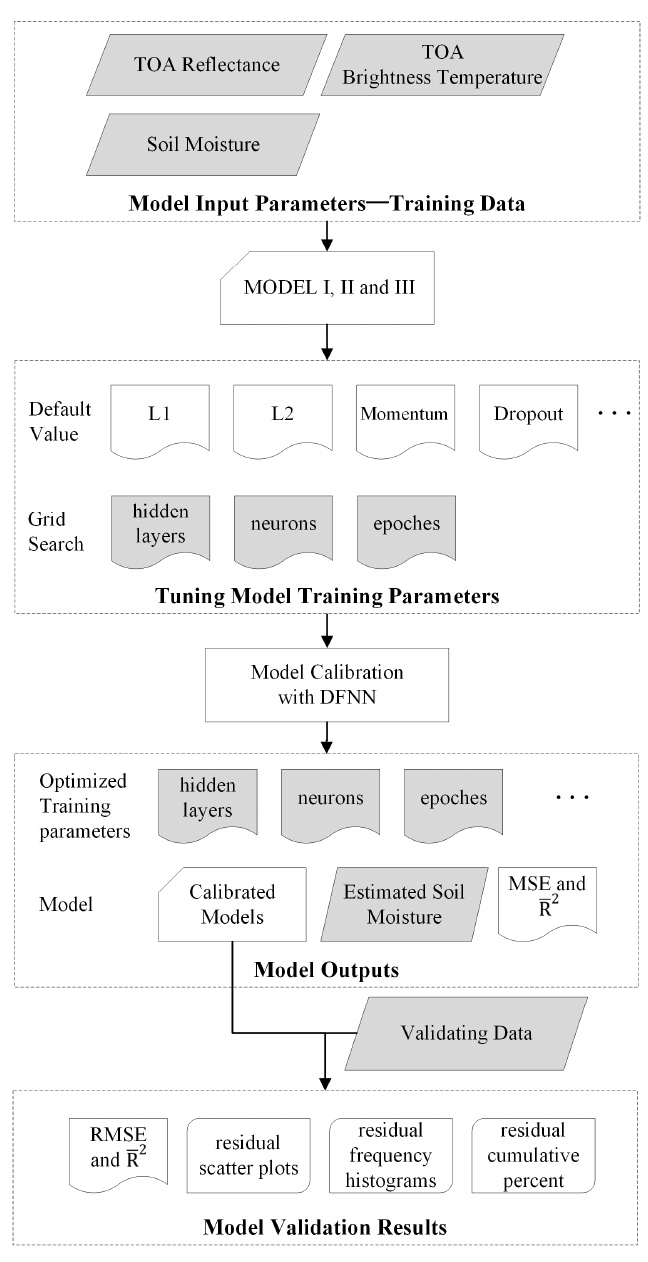
Figure 3. The procedure of model building.